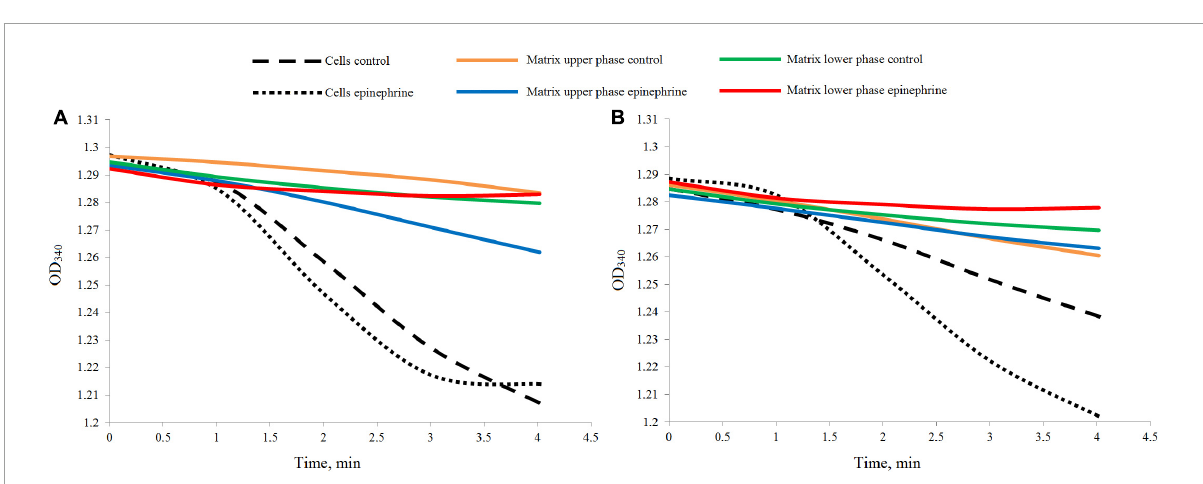
FIGURE2 Differences in the dynamics of the LDH reaction measured in the biofilm cell biomass and matrix samples. (A) Samples after 24 h of incubation. (B) Samples after 72 h of